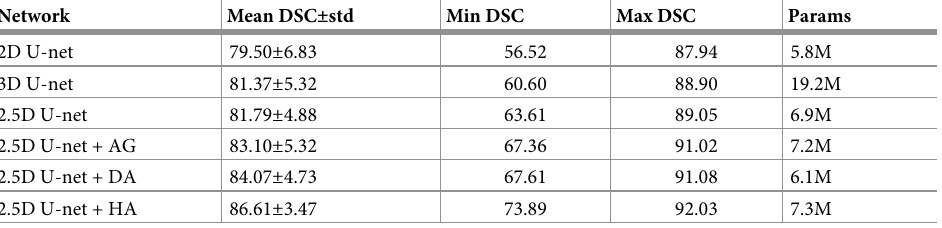
Table 3. Ablation study of our proposed 2.5D U-net and proposed attention module. AG: The attention gate pro- posed in [24]. DA: The dual attention module proposed in [22]. HA: Our proposed attention module. Params: The number of parameters.